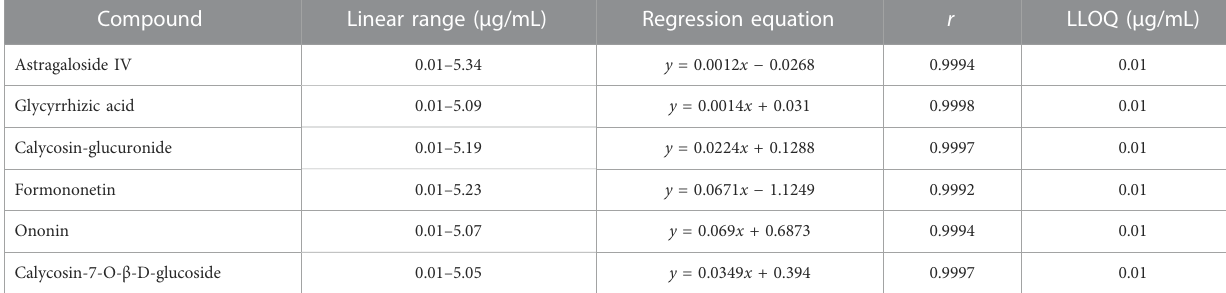
TABLE 3 Regression equation, linear range, and LLOQ for six components in liver microsomal samples.